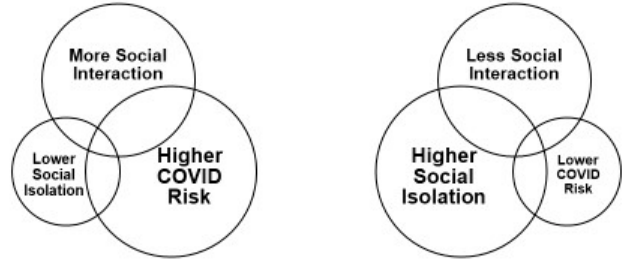
Figure 2. The COVID-19 Social Connectivity Paradox 20